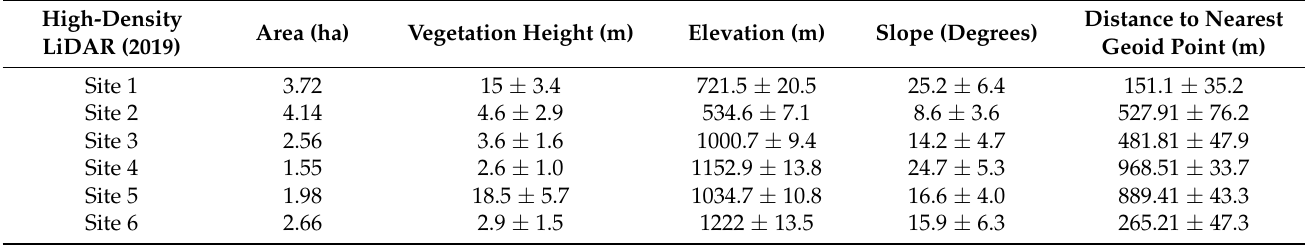
Table 1. Main properties of the study areas (sites) according to the high-density LiDAR data (2019). Area in hectares (ha) and mean values and standard deviation of vegetation height (m), elevation (m), slope (degrees) and distance to nearest national geoid point (m) are